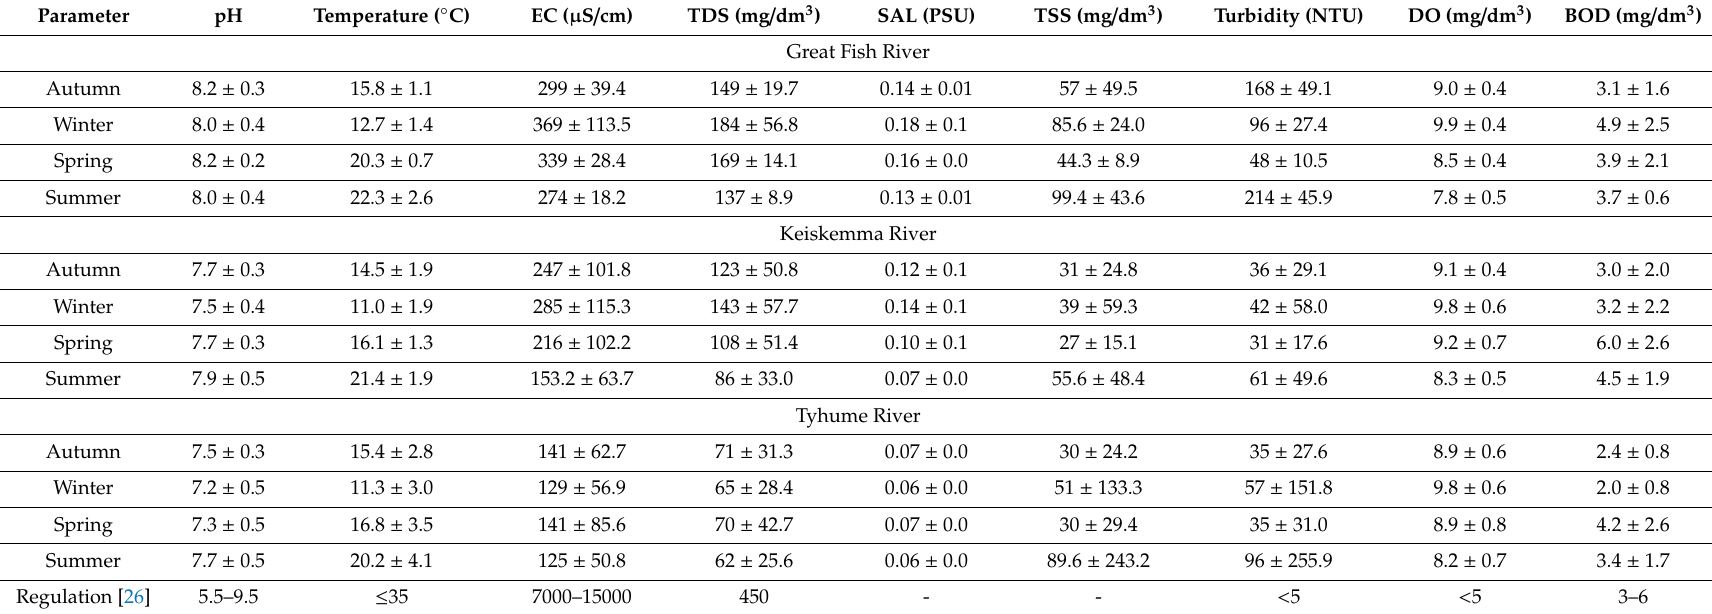
Table 2. Physicochemical parameters of the Great Fish, Keiskemma and Tyhume rivers across the four